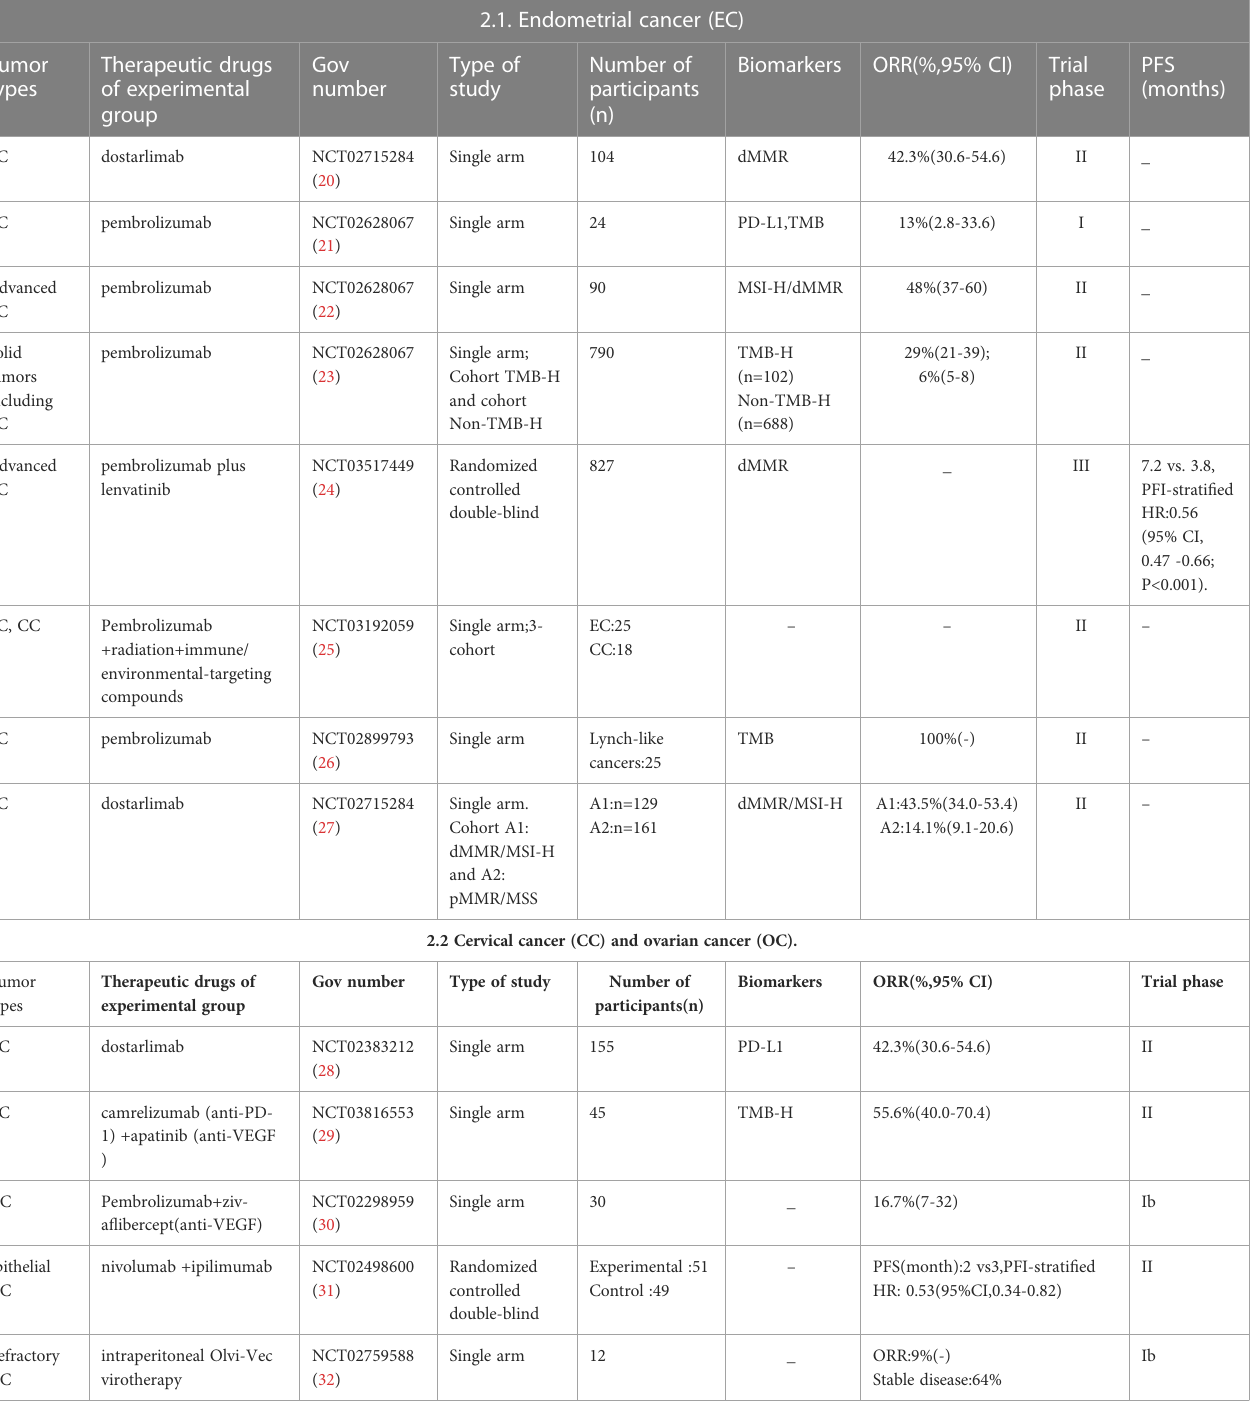
TABLE 2 Clinical studies on the immunotherapy of gynecological